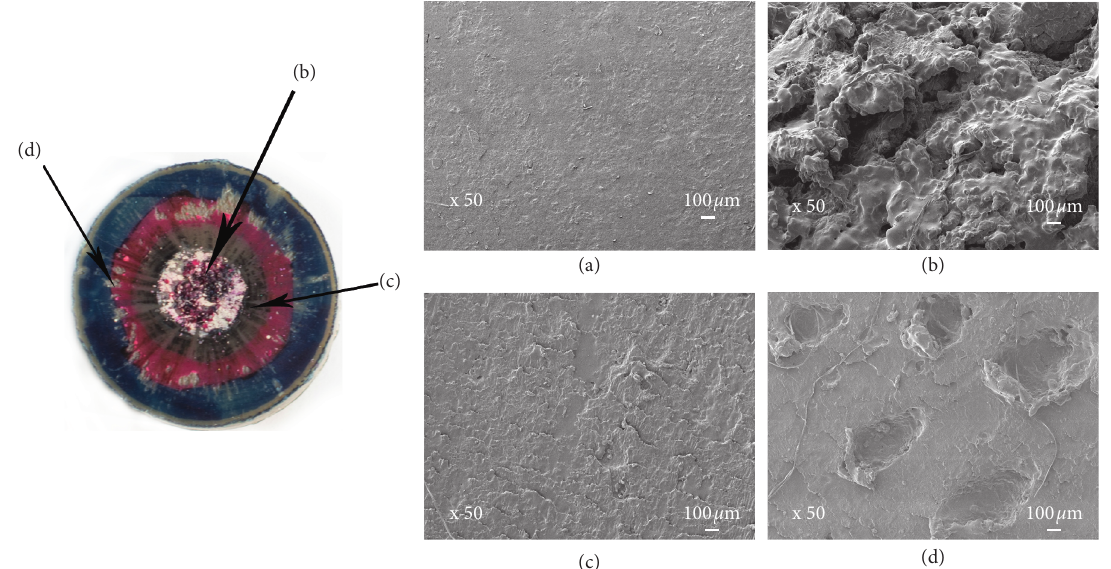
Figure 4: SEM images of surface damages of S-SBR 2 sample before and after 10000 compressive test cycles: (a) before fatigue test, (b) central region after test, (c) showing the wave, and (d) showing the voids.